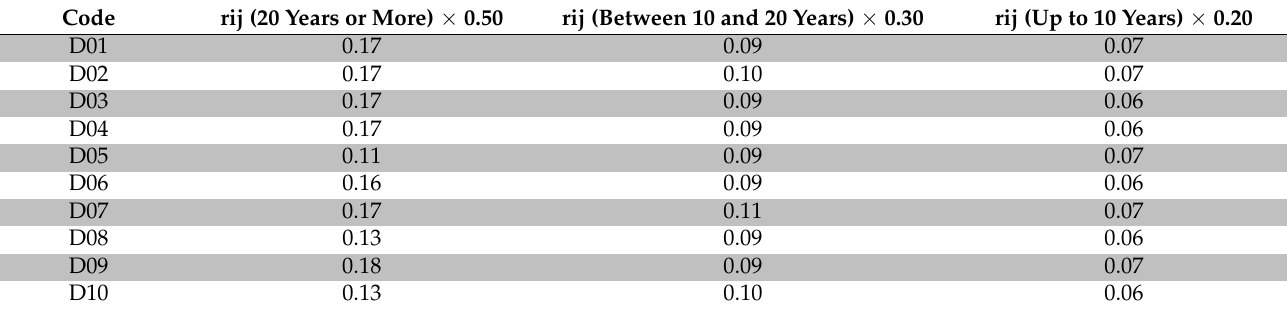
Table 5. Matrix V weighted values.